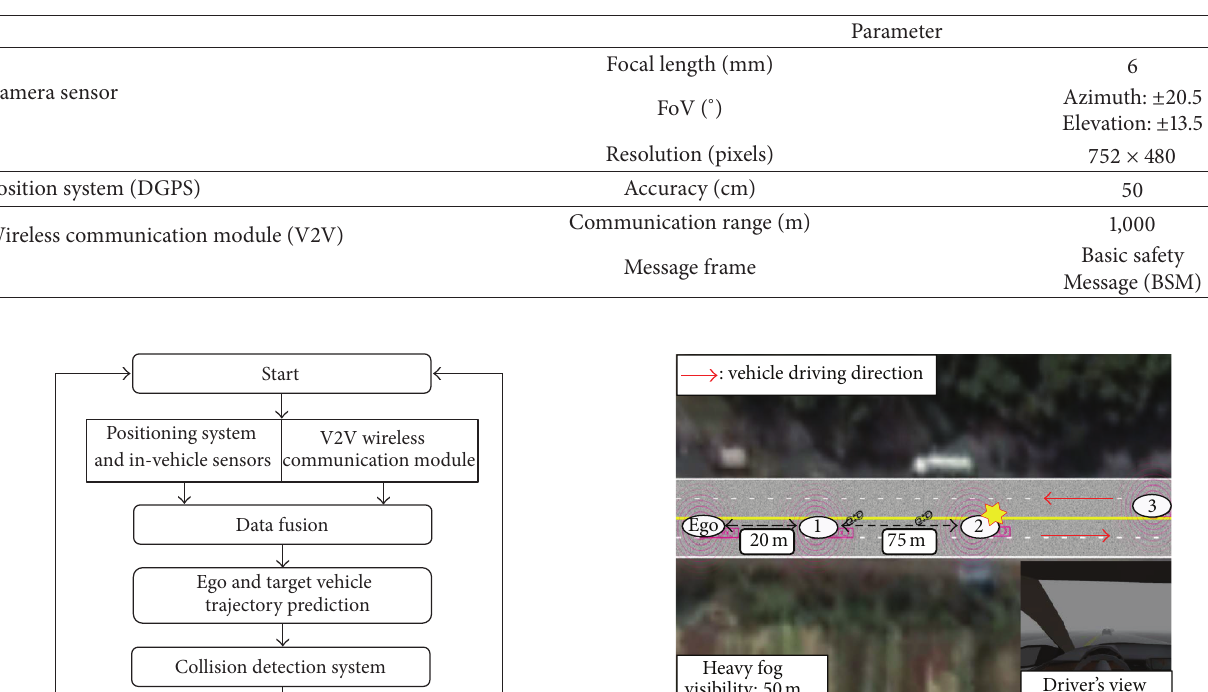
Table 3: Module and sensor specifications of V2V communication-based AEB system.